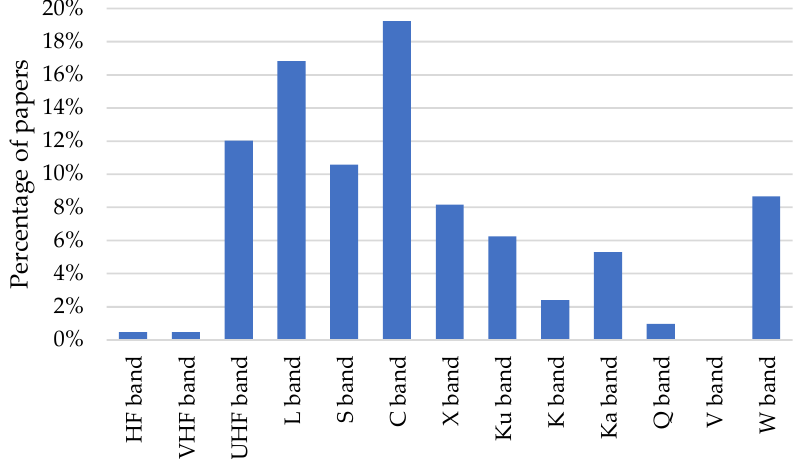
Figure 9. Number of papers in terms of operative bandwidth.